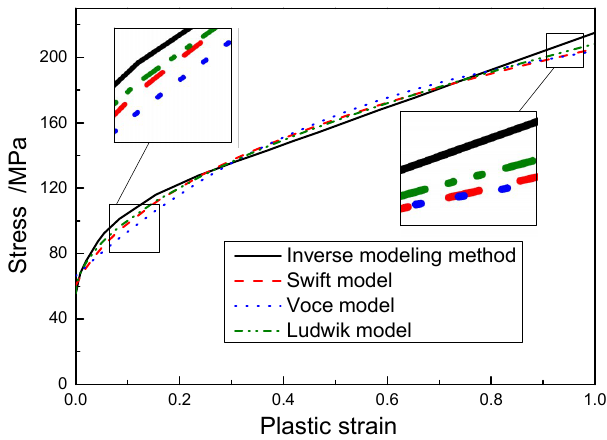
Table 1. Other phenomenological constitutive models.